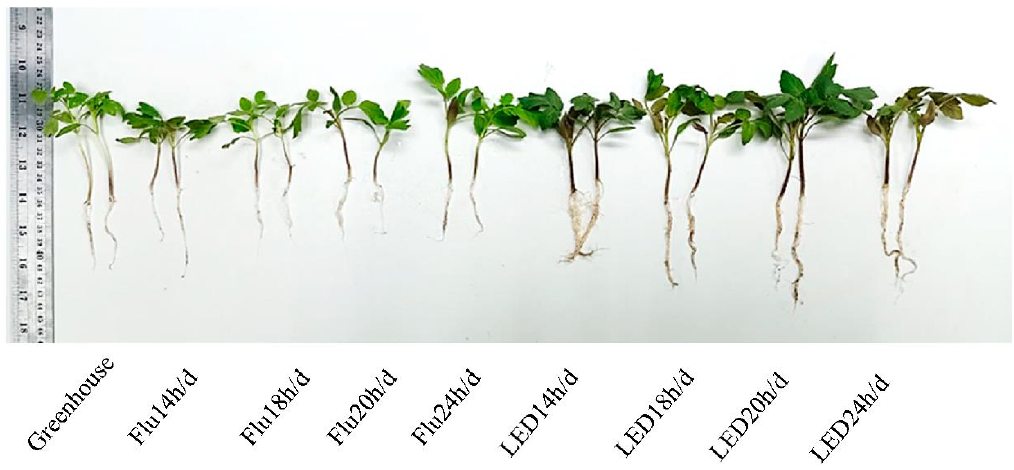
Figure 3. The phenotype of tomato seedling growth under different photoperiods of 14 – 24 h/d at 14 days. Flu: fluorescent light at 150 µmol/m 2 /s, LED: LED light at 200 µmol/m 2 /s, ratio R60:B40.